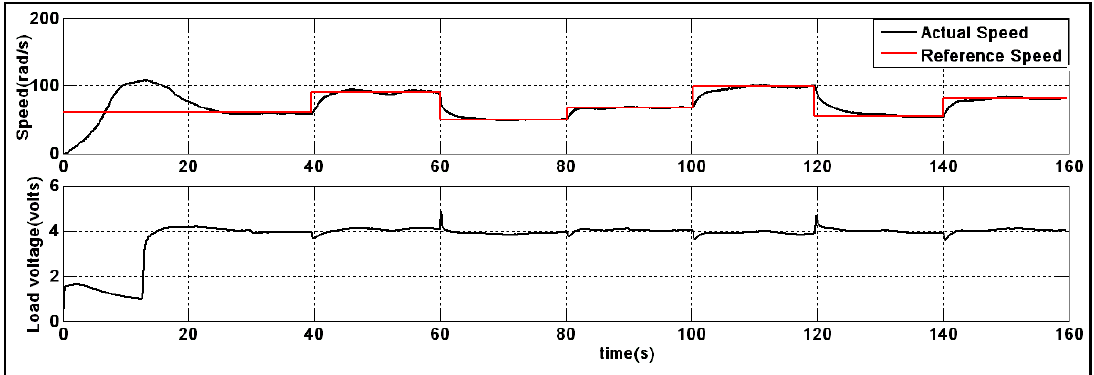
Figure 10. Variable load banks.